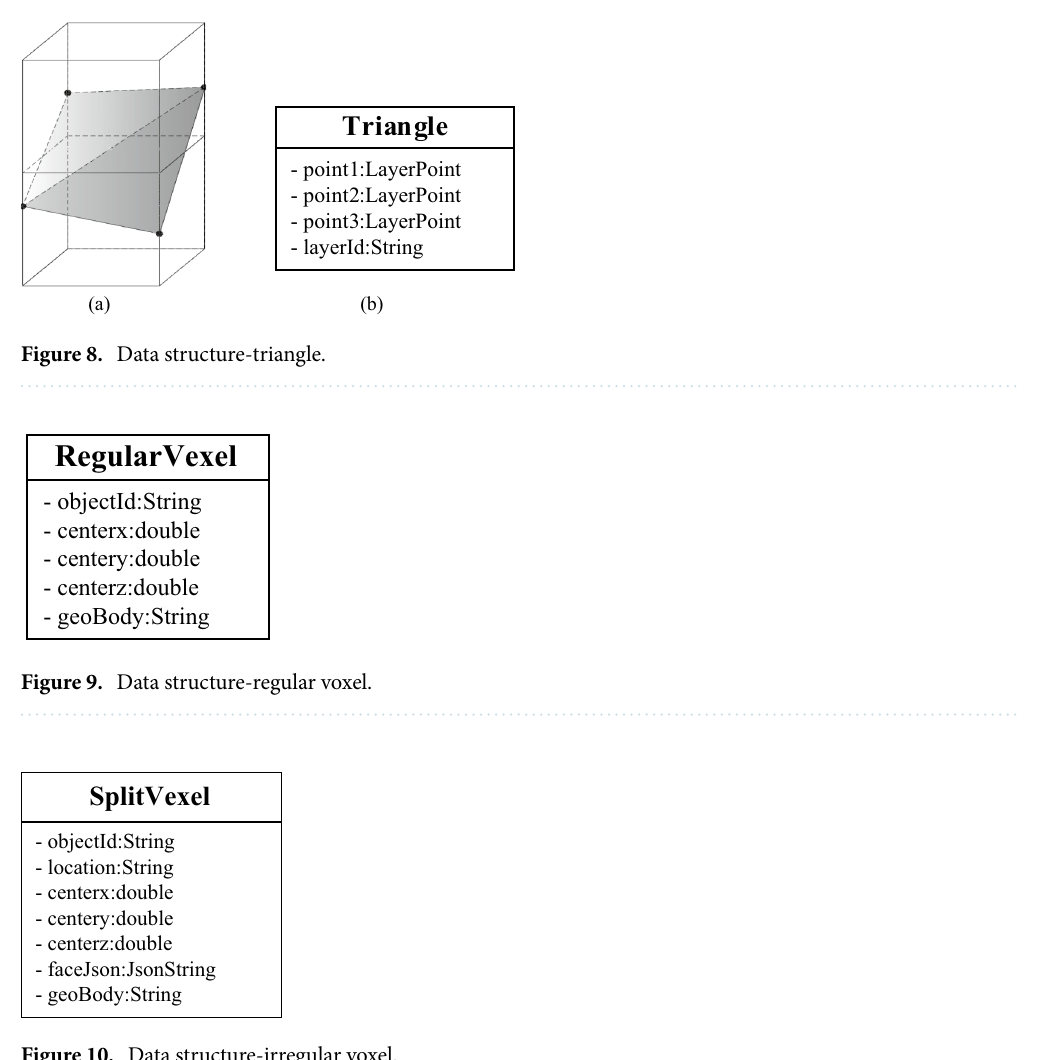
Figure 10. Data structure-irregular